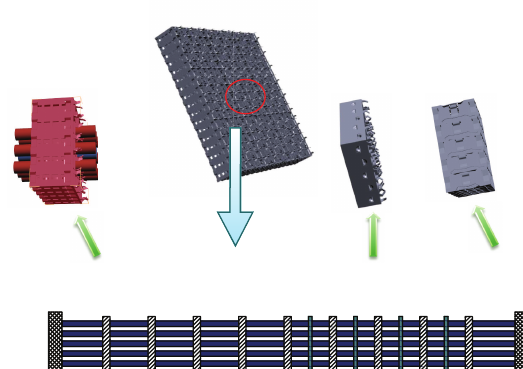
Figure 4: A rod bundle assembly with grids of different designs located at various elevations with different grid spans and different grid